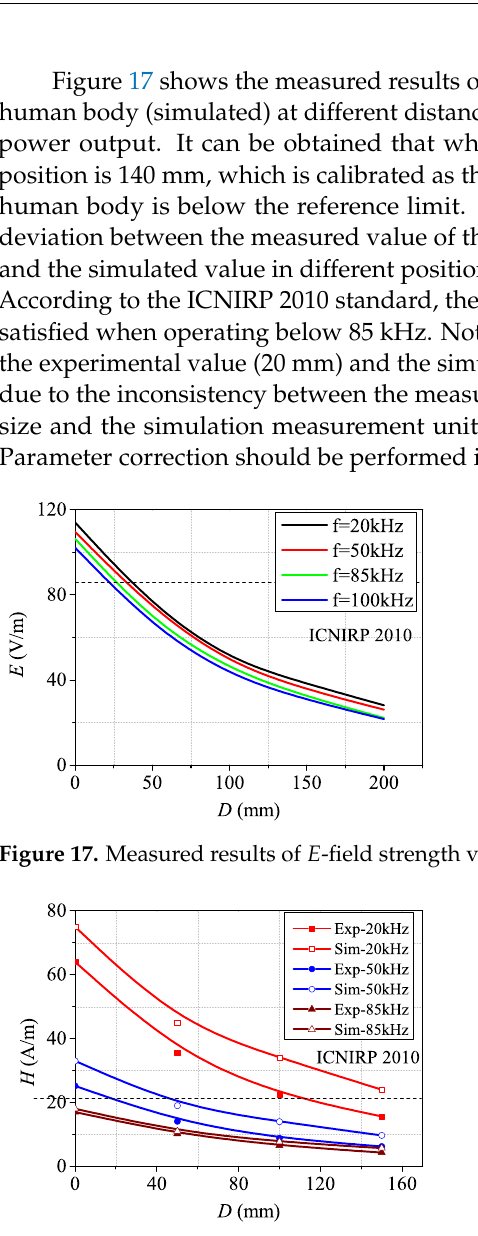
Figure 18. Measured results of H -field strength versus distance and operating